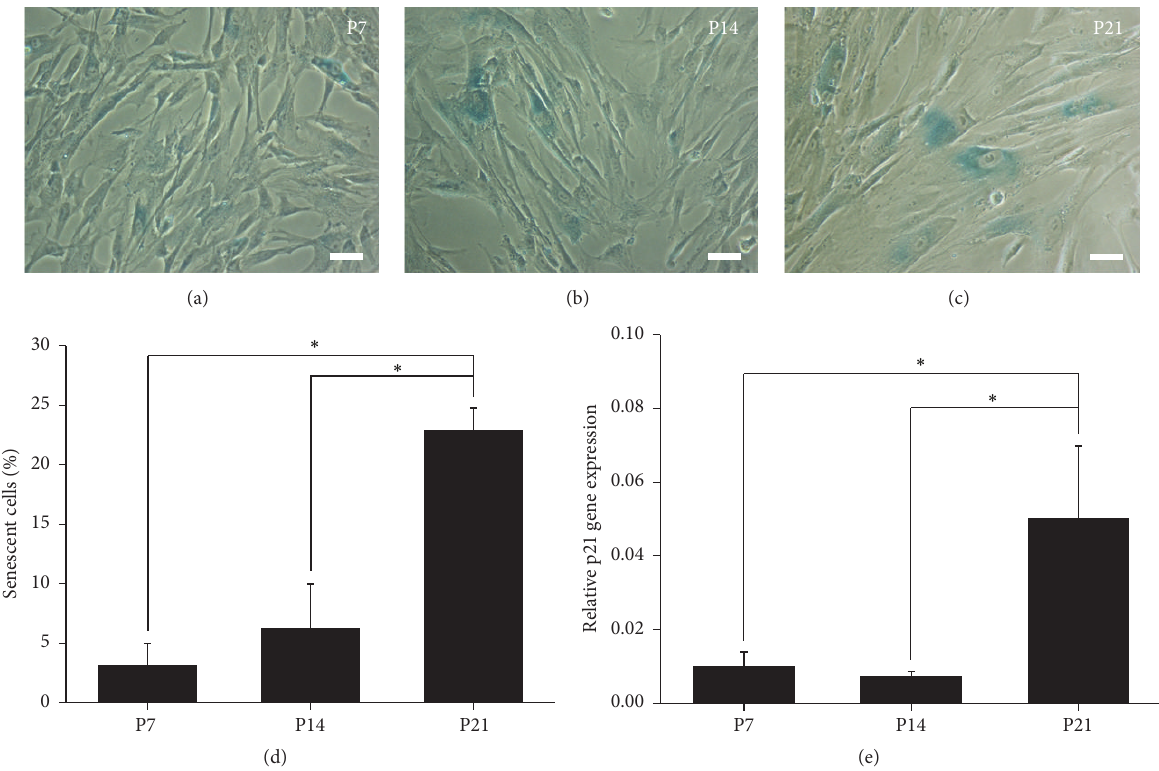
Figure 2: SA- 𝛽 -gal staining, percentage of senescent cells, and p21 gene expression in WJ MSCs (Wharton’s jelly-derived mesenchymal stem cells) in the early, middle, and late phases. (a) SA- 𝛽 -gal staining showed that there were few senescent cells in WJ MSCs in the early phase, (b) senescent cells were found in the middle phase, and (c) more senescent cells appeared in the late phase. Bar: 100 𝜇 m. (d) The percentage of senescent cells in WJ MSCs in the late phase was 22.9 ± 1.9 %, significantly higher than 3.2 ± 1.8 % in the early phase and 6.2 ± 3.8 % in the middle phase ( ∗ 𝑃 < 0.05 ). (e) The gene expression of p21 was upregulated in WJ MSCs in the late phase, which was also significantly higher than that in the early and middle phases ( ∗ 𝑃 < 0.05